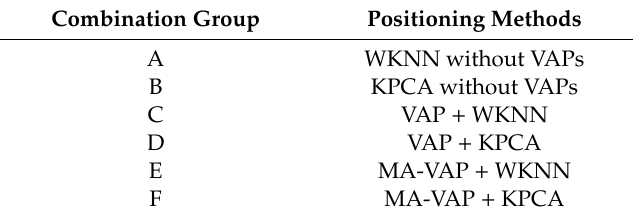
Table 3. The di ff erent combinations of several positioning methods used in the experiments.